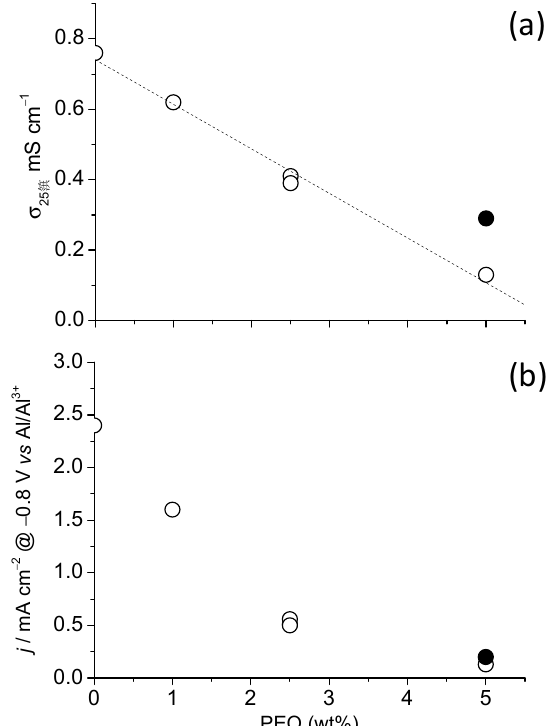
Figure 5. ( a ) Conductivity σ and ( b ) current density j , measured at − 0.8 V vs. Al/Al 3+ for different PGEs as a function of the wt% PEO. Solid black symbols correspond to PEO1-5/U150, the only liquid electrolyte in this series.